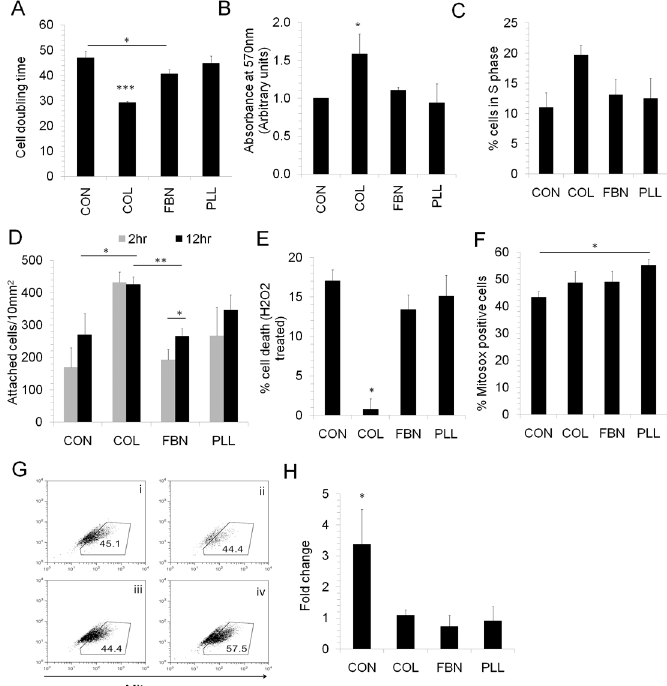
Fig 1. Proliferation and cell survival. MSC were seeded in equal numbers (1000 cells/cm 2 ) on tissue culture dishes which were left uncoated (CON) or coated with collagen (COL, 2ug/cm2), fibronectin (FBN (100ng/cm2) or Poly-l-lysine (PLL, 100ng/cm2) for 48 – 72 hours. (A) Doubling time was calculated by cell counting of MSC grown on different matrices. (B) Cell proliferation on different matrices were analysed by MTT assay. * p < 0.05 represents cell proliferation significantly higher in cells grown on COL compared to CON, FBN and PLL surfaces. (C) MSC cultured on COL, FBN and PLL and TC surface (CON) was